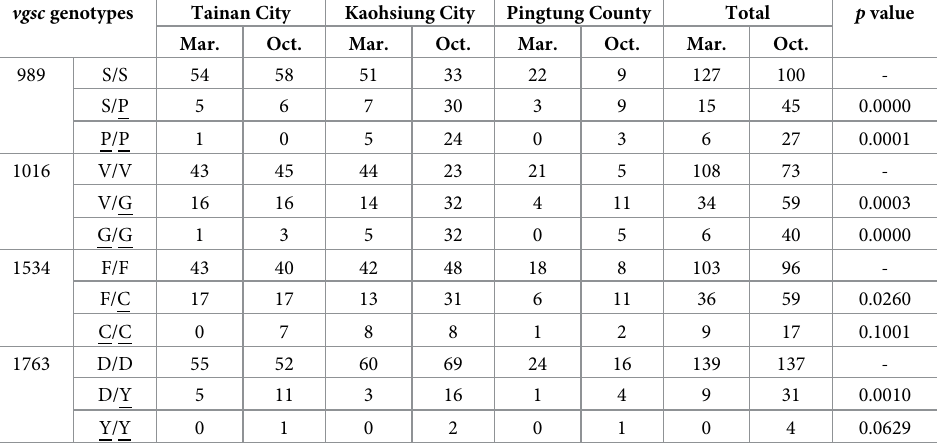
Table 1. The distribution of vgsc genotypes (for single amino acid sites) in field-collected male Ae . aegypti mos- quitoes in March and in October. Underlined letter represents the mutant alleles in each position. vgsc genotypes